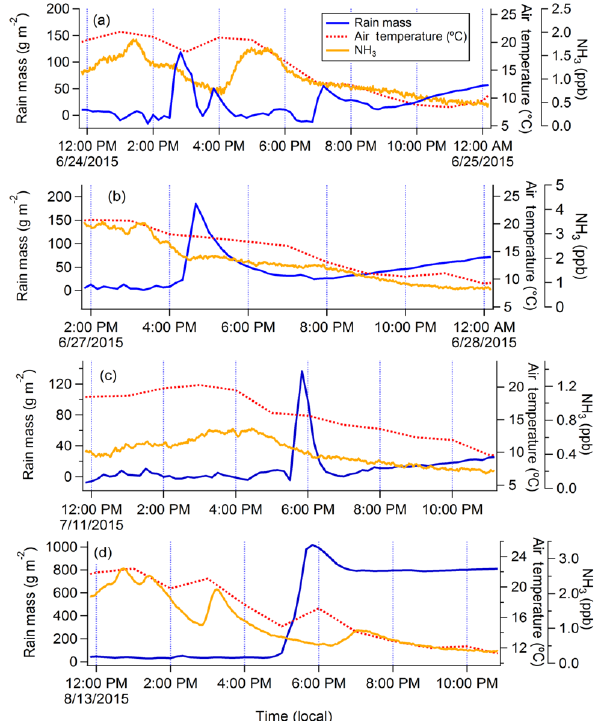
Figure 6. Rain accumulation (blue, gm − 2 ) , NH 3 mixing ratio (or- ange, ppbv), and air temperature (red, ◦ C) during the afternoon and evening on a) 24 June, (b) 27 June, (c) 11 July, and (d) 13 Au- gust 2015; 100gm − 2 is equivalent to 0.1mm of